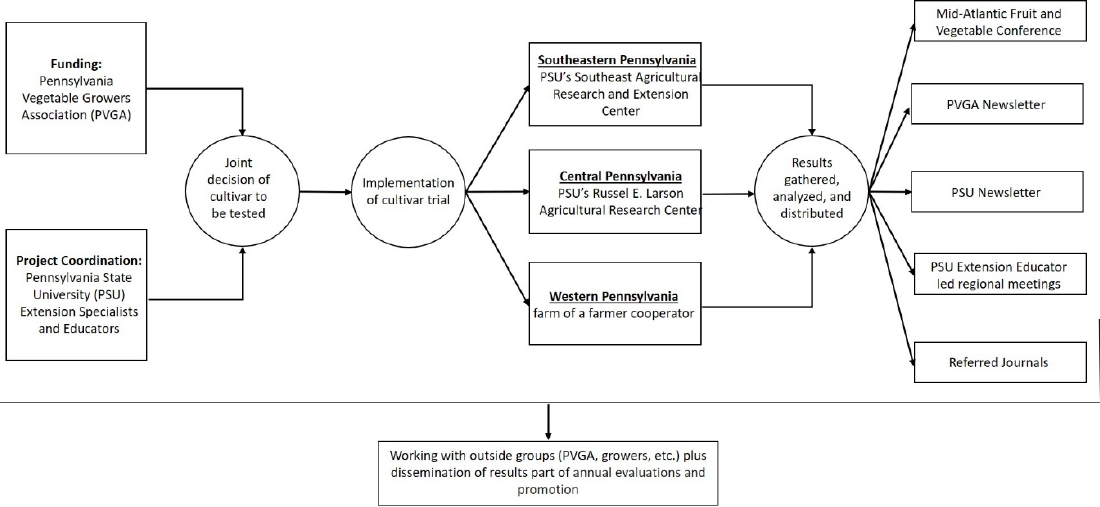
Figure 1. Components of the model created and used since 2008 by a team of scientists at Pennsylvania State University for conducting annual statewide cultivar evaluations. Key elements included long-term funding from a farmer organization (Pennsylvania Vegetable Growers Association), building relationships with farmers and seed company representatives, conducting evaluations at three locations, and disseminating results through Extension and academic outlets. This model has resulted in positive impacts for Pennsylvania’s vegetable industry and the annual evaluations of team members.